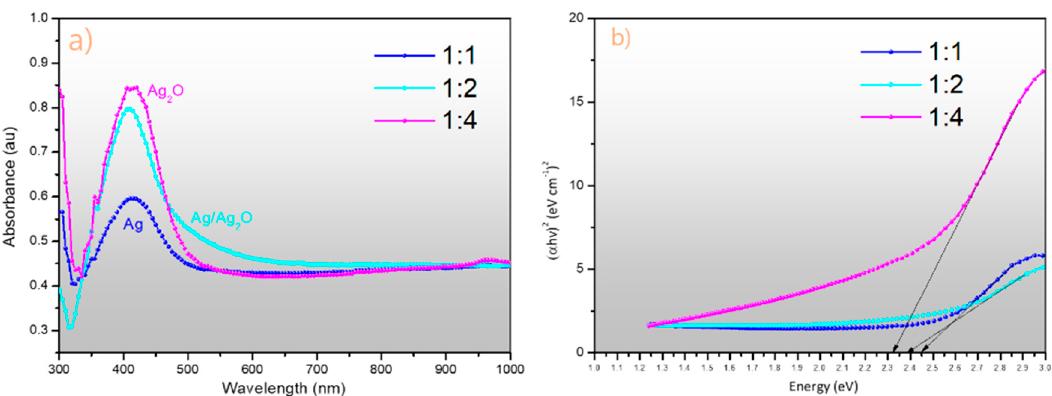
Figure 5. ( a ) Ultraviolet–visible light (UV–Vis) spectra of synthesized nanoparticles at different extract ratios: AgNP at 1:1 ratio, AgNP–Ag 2 ONP at 1:2 ratio, Ag 2 ONP at 1:4 ratio; ( b ) Tauc plot for band gap determination.